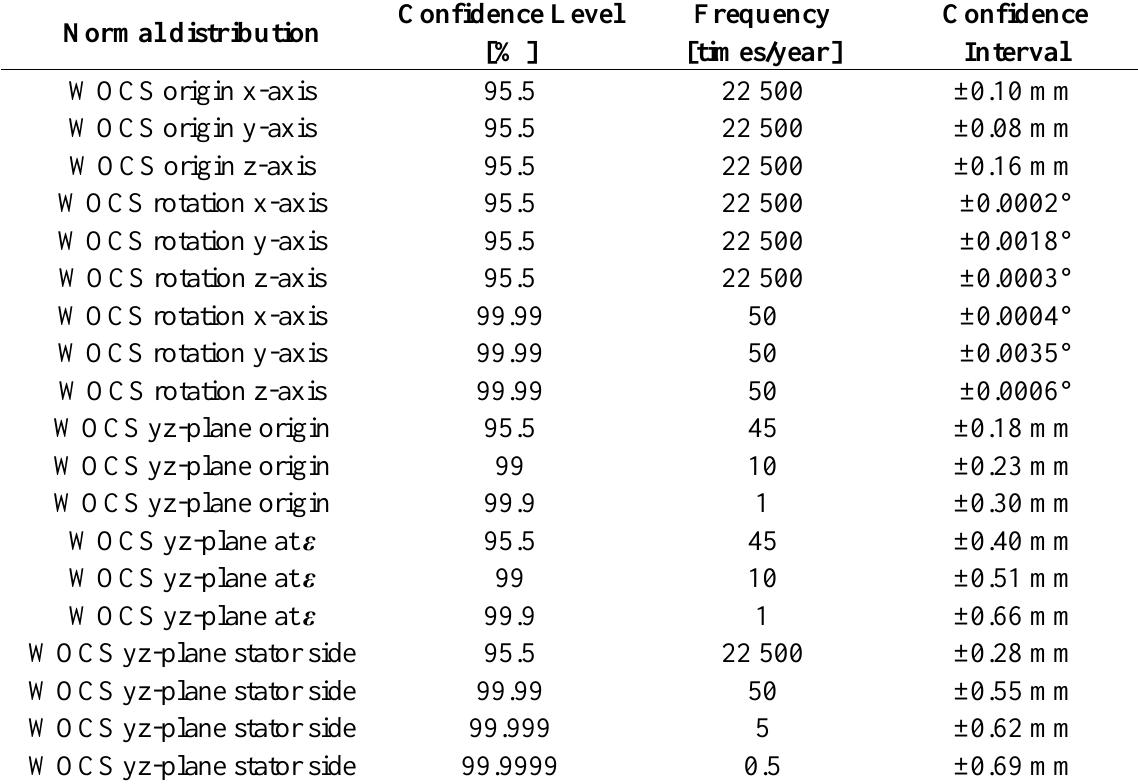
Table 1. Confidence intervals for the calculated absolute positioning errors from the UU WEC stator section positional calibration experiments, based on 400 measurements. The frequency number represents approximately how often an error outside the confidence interval will occur in one cable winding robot cell in full operation during one